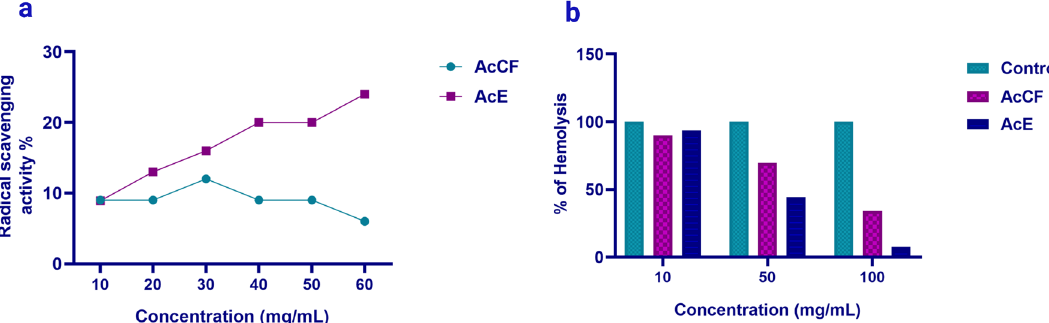
Figure 1. In vitro biological activities of AcCF and AcE. ( a) Antioxidant activity assayed by radical scavenging activity of DPPH. (b) Anti-inflammatory activity using heat-induced